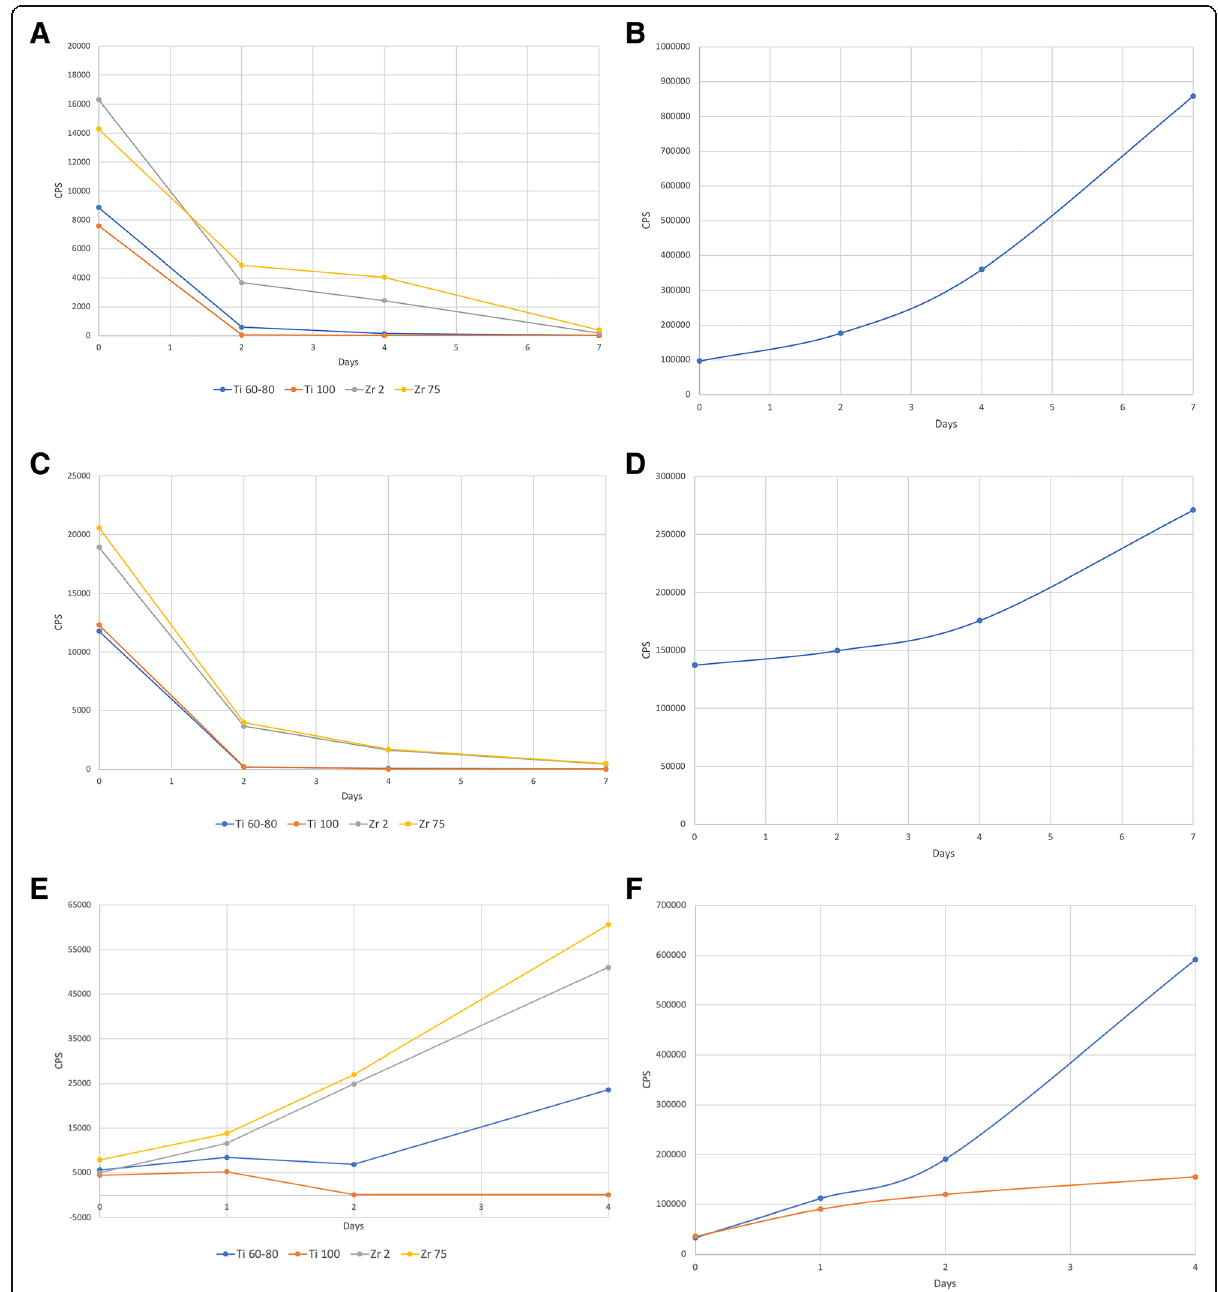
Fig. 1 Mitochondrial activity expressed as median luminescent output (counts per second -CPS) of SaOs-2 and HGF in different groups. a Test groups (SaOs-2). b Control group (SaOs-2). c Test groups (HGF). d Control group (HGF). e Test groups (THP-1). f Control groups